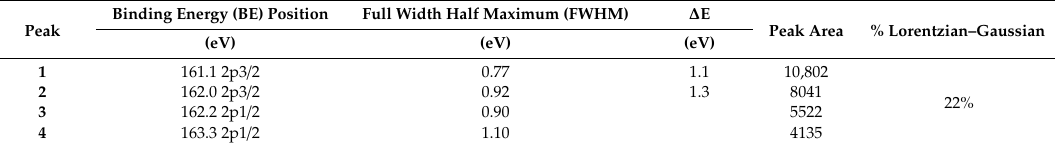
Table 2. Details of the fitting peaks of S before the HER reaction.